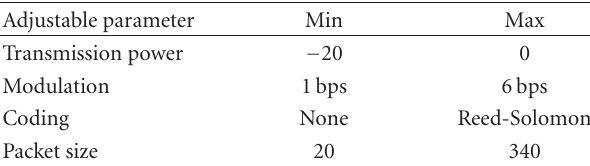
Table 2: Ranges of reconfigurable SDR